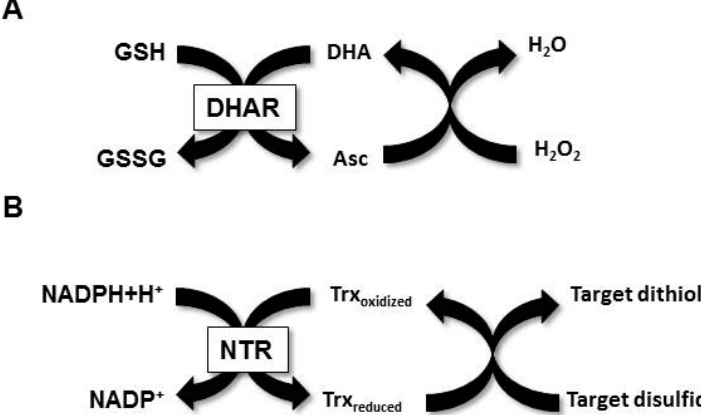
Figure 1. Ascorbate- and thioredoxin-dependent reducing pathways. ( A ) Dehydroascorbate reductase (DHAR) regenerates reduced ascorbate by oxidizing reduced glutathione (GSH) to disulfide-linked oxidized glutathione (GSSG). Ascorbate (Asc) can then be oxidized back to dehydroascorbate (DHA) upon reaction with a molecule H 2 O 2 or other oxidants. ( B ) Reduced Trx regenerates an oxidized target disulfide bond to a dithiol. Trx itself is then reduced to its active form by a nicotinamide adenine dinucleotide phosphate (NADPH)-dependent thioredoxin reductase. Nicotinamide adenine dinucleotide phosphate (NADPH)-dependent thioredoxin reductase (NTR) and thioredoxin (Trx) constitute a versatile multi-enzymatic NTS that has been extensively